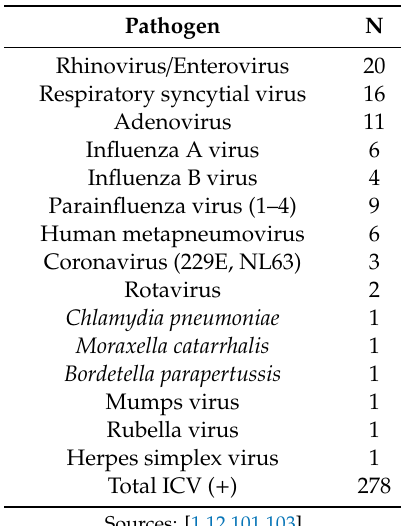
Table 2. Summary of co-infections seen in patients with influenza C virus (ICV)